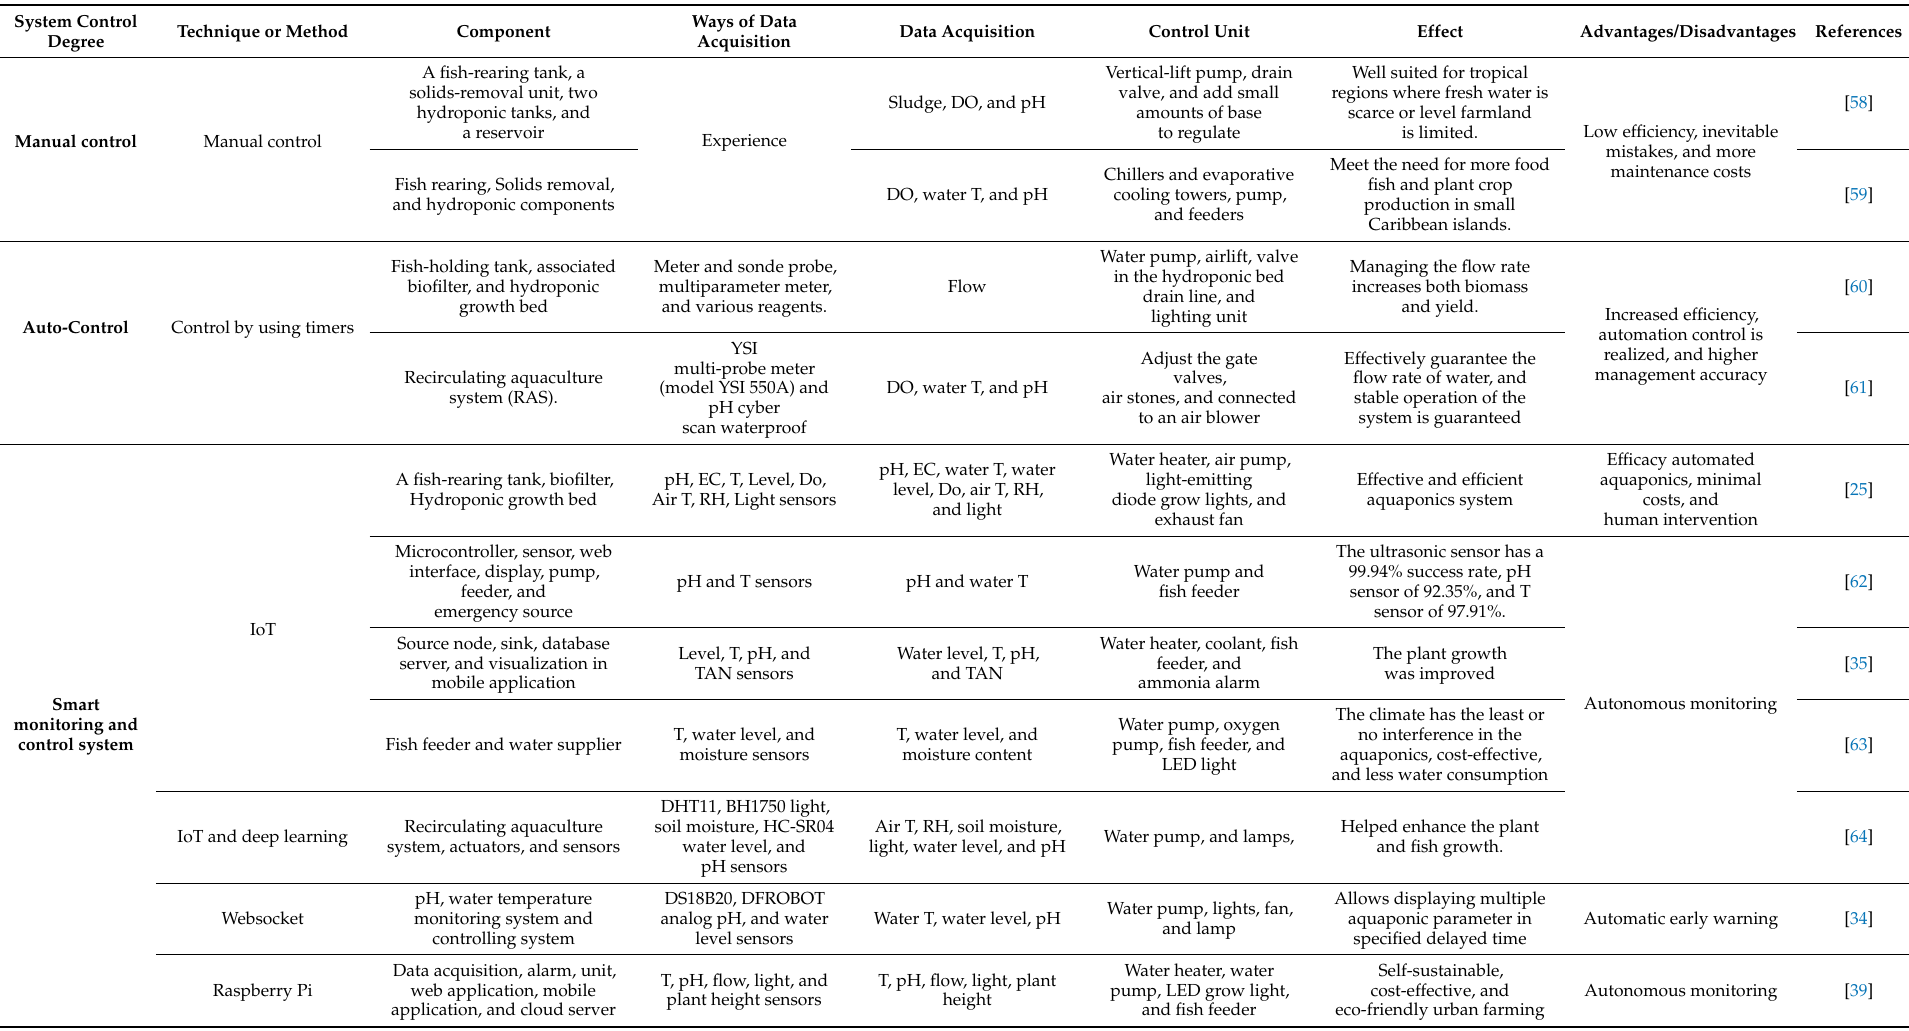
Table 4. Summary of different control degrees implemented in traditional and modern aquaponic